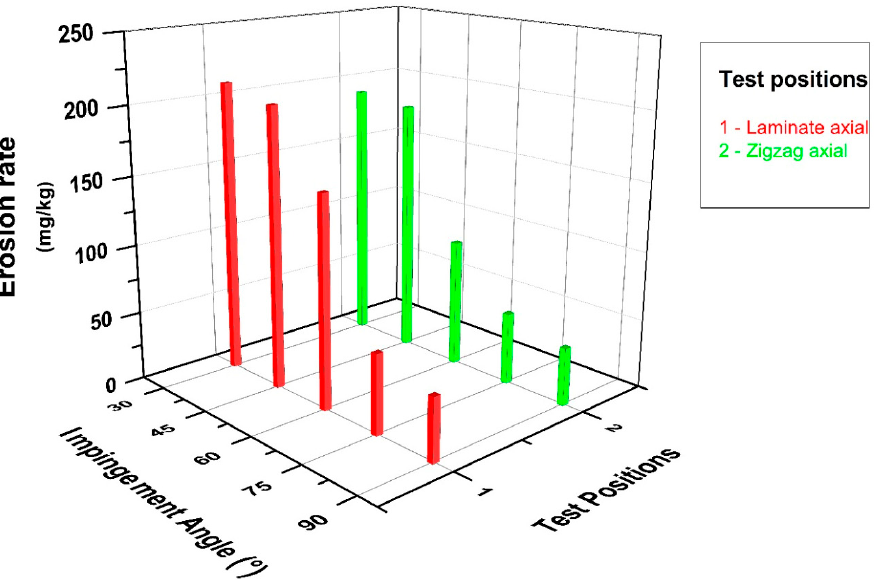
Figure 8. BFR/EP composite pipe outer surface axial orientation erosion rate–impingement angle relationship.